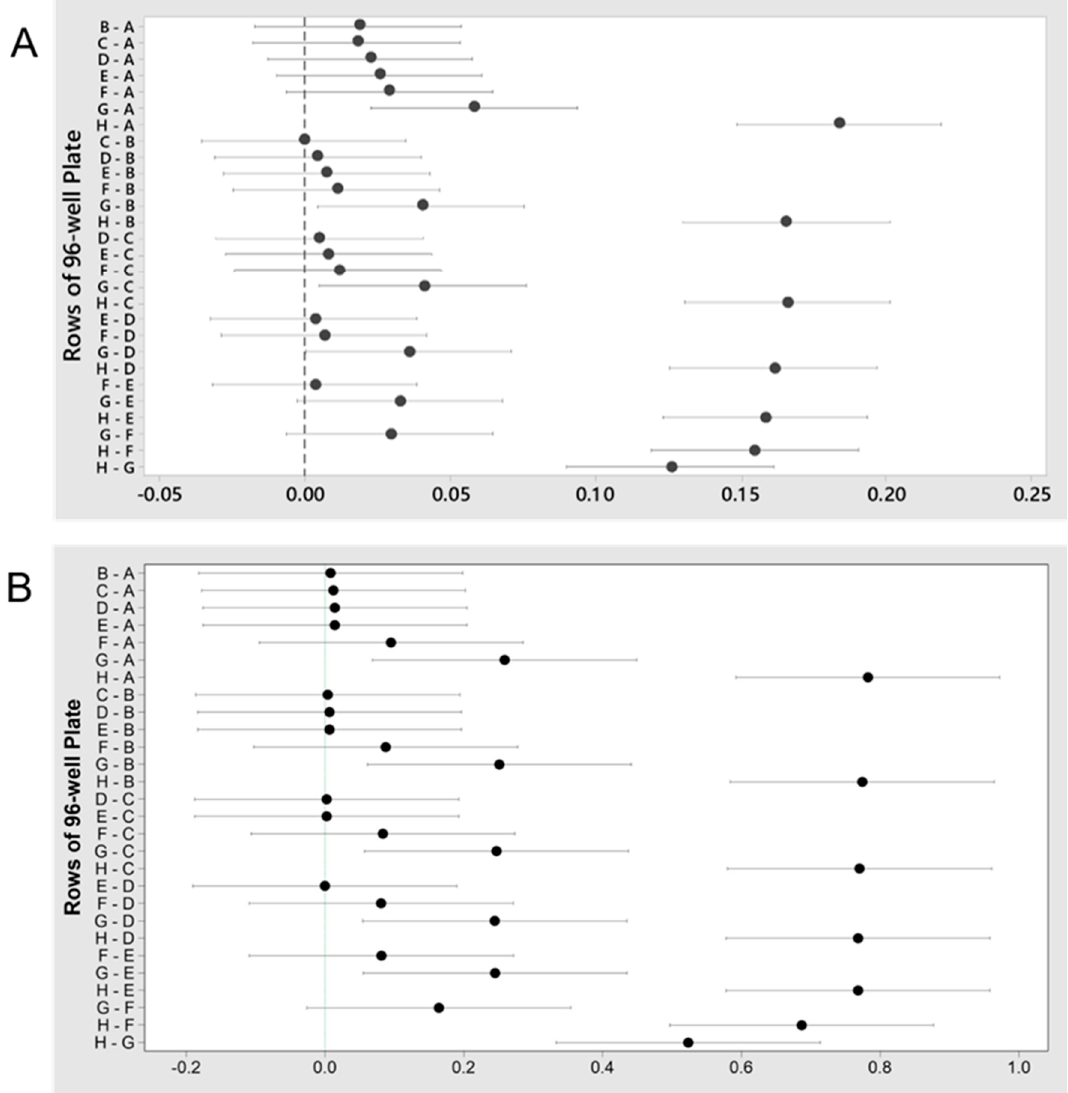
Figure 5. Fisher individual 95% confidence intervals for the MIC values from the challenge plate of C. portucalensis containing ( A ) cotrimoxazole; the MIC is determined to be between 15.6 and 7.8 μ g/mL (rows G and H) due to effect of antibiotic causing a lack of growth and a significant difference in the absorbance between rows G and H; ( B ) neomycin; the MIC is determined to be between 31.3 and 7.8 μ g/mL (rows F and H) due to a lack of growth. More data is required to determine if the MIC is between 31.3 and 15.6 μ g/mL (rows F and G) due to near significant differences in the absorbance between rows F and G.